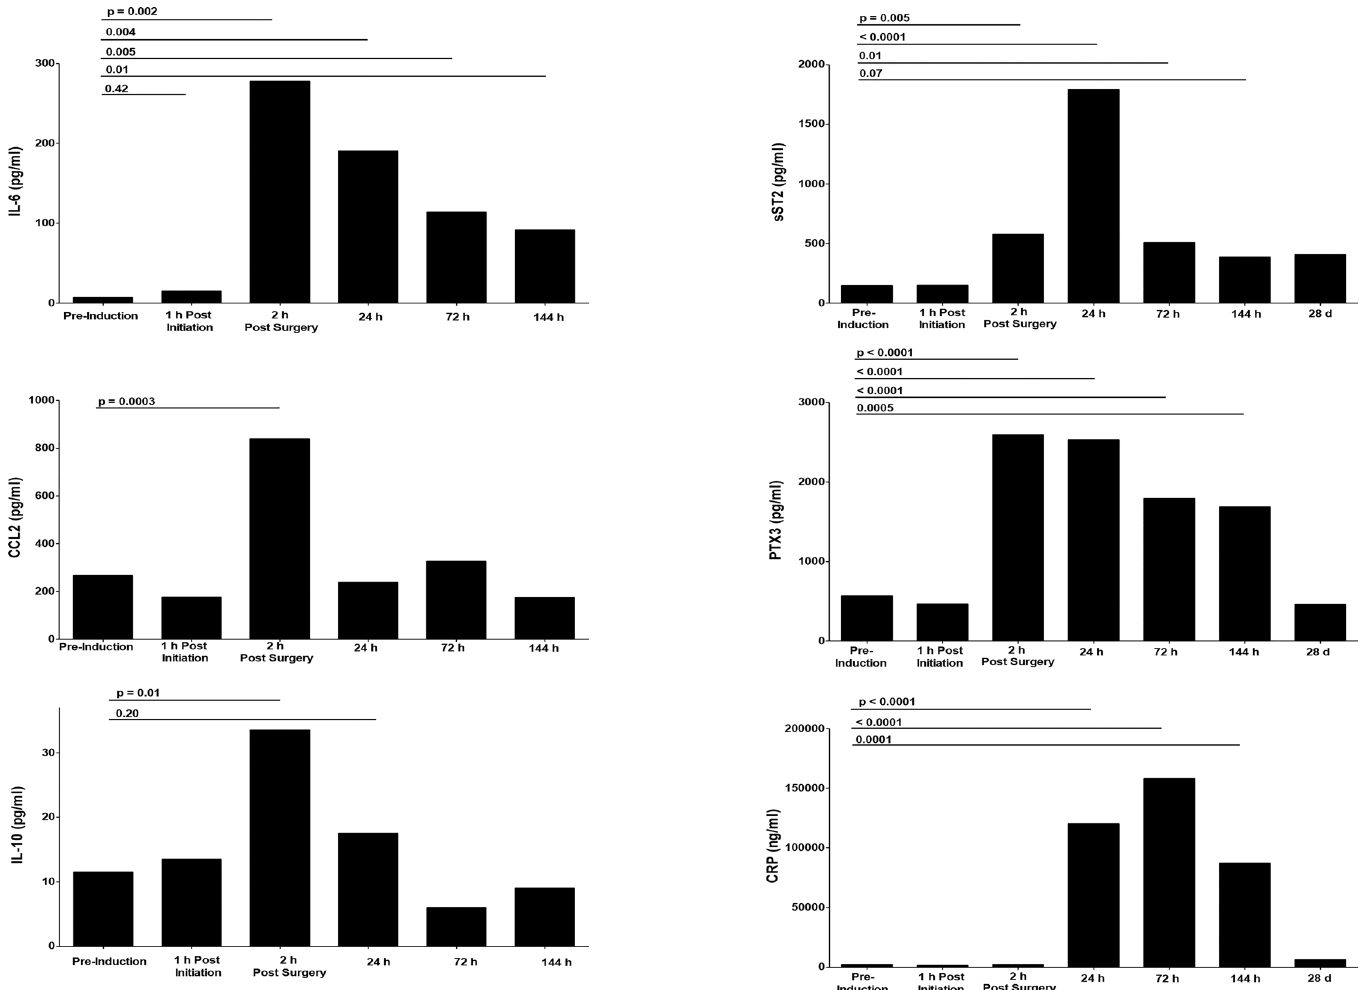
Fig 2. Kinetics of in vivo chemokine, cytokine and acute phase protein responses following CABG. Serum obtained at baseline and the time points indicated was analysed as described at Materials and Methods to assess response kinetics for each biomarker individually. All levels are compared to baseline/study entry conditions. Median responses and statistical significance (Wilcoxon) of longitudinal comparisons relative to pre-induction baseline are shown.